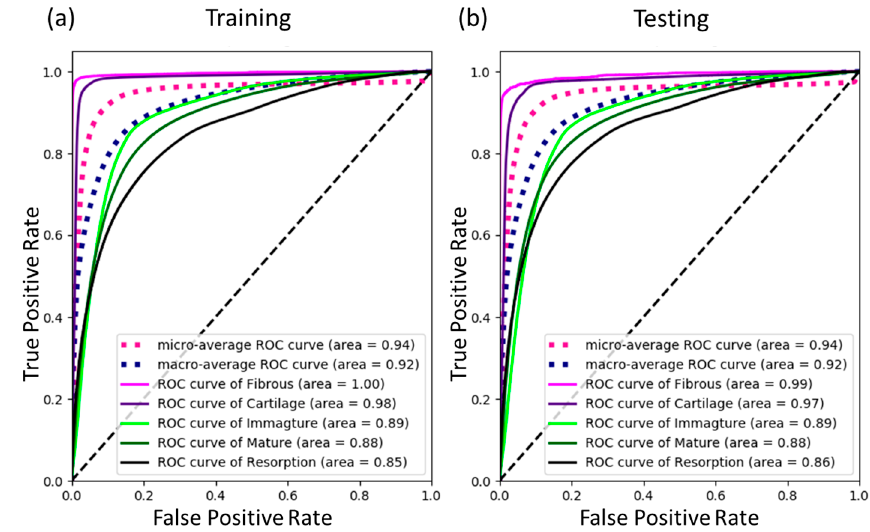
Figure 5. ROC curves and the corresponding AUC values for the day-by-day continuous prediction for each tissue phenotype.